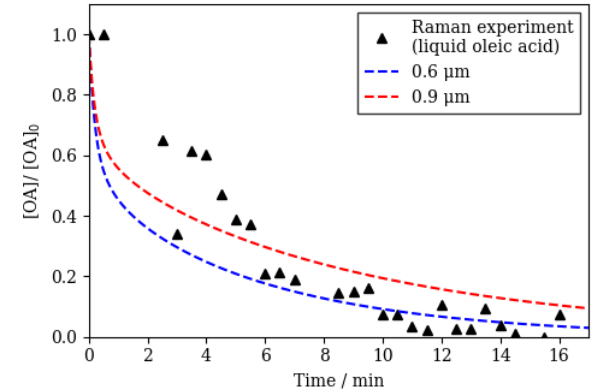
Figure 3. Kinetic decay plot of the ozonolysis of liquid oleic acid measured by Raman microscopy. Model output for two film thick- nesses (0.6 and 0.9µm) with liquid oleic acid diffusion parameters ( D Y, liq = 1 . 53 × 10 − 9 cm 2 s − 1 , D X, liq = 1 . 00 × 10 − 5 cm 2 s − 1 , re- placing D Y, lam and D X, lam ). Experimental [ O ] 3 = 77 ±